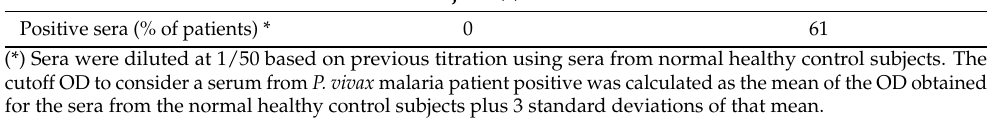
Table 2. Detection of anti-Vir14 specific antibodies in the sera of P. vivax malaria patients. Normal Healthy Control Subjects (6) Positive sera (% of patients)